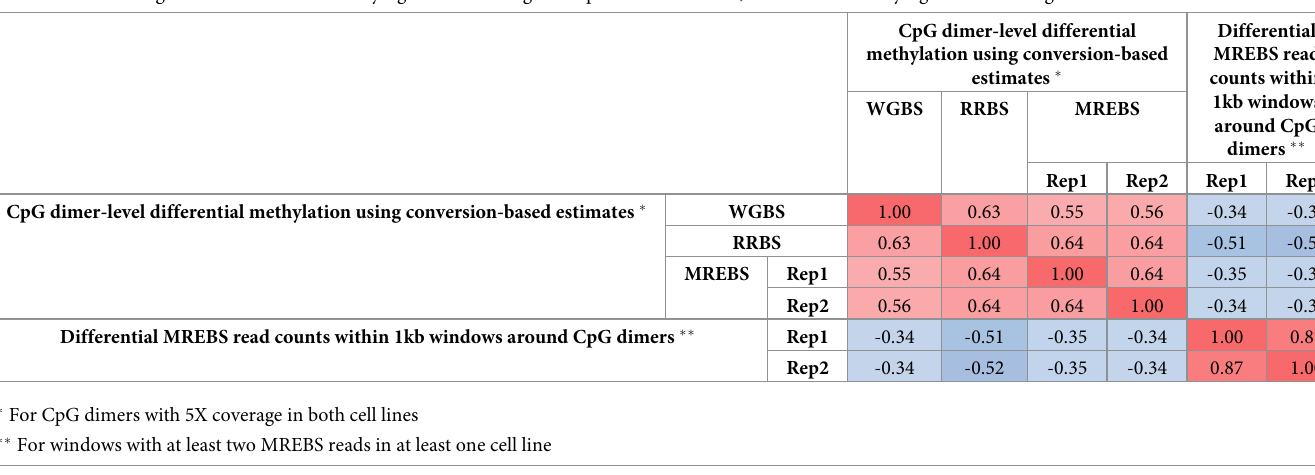
Table 2. CpG dimer-level correlations between differential values for all bisulfite sequencing library pairs. Pearson correlation values between WGBS, RRBS, and MREBS differential CpG dimer-level methylation estimates (EARLY—ESC), as well as differential read counts between all CpG dimers with at least two MREBS reads within a surrounding 1kb window. Red intensity signifies the strength of a positive correlation, while blue intensity signifies the strength of the